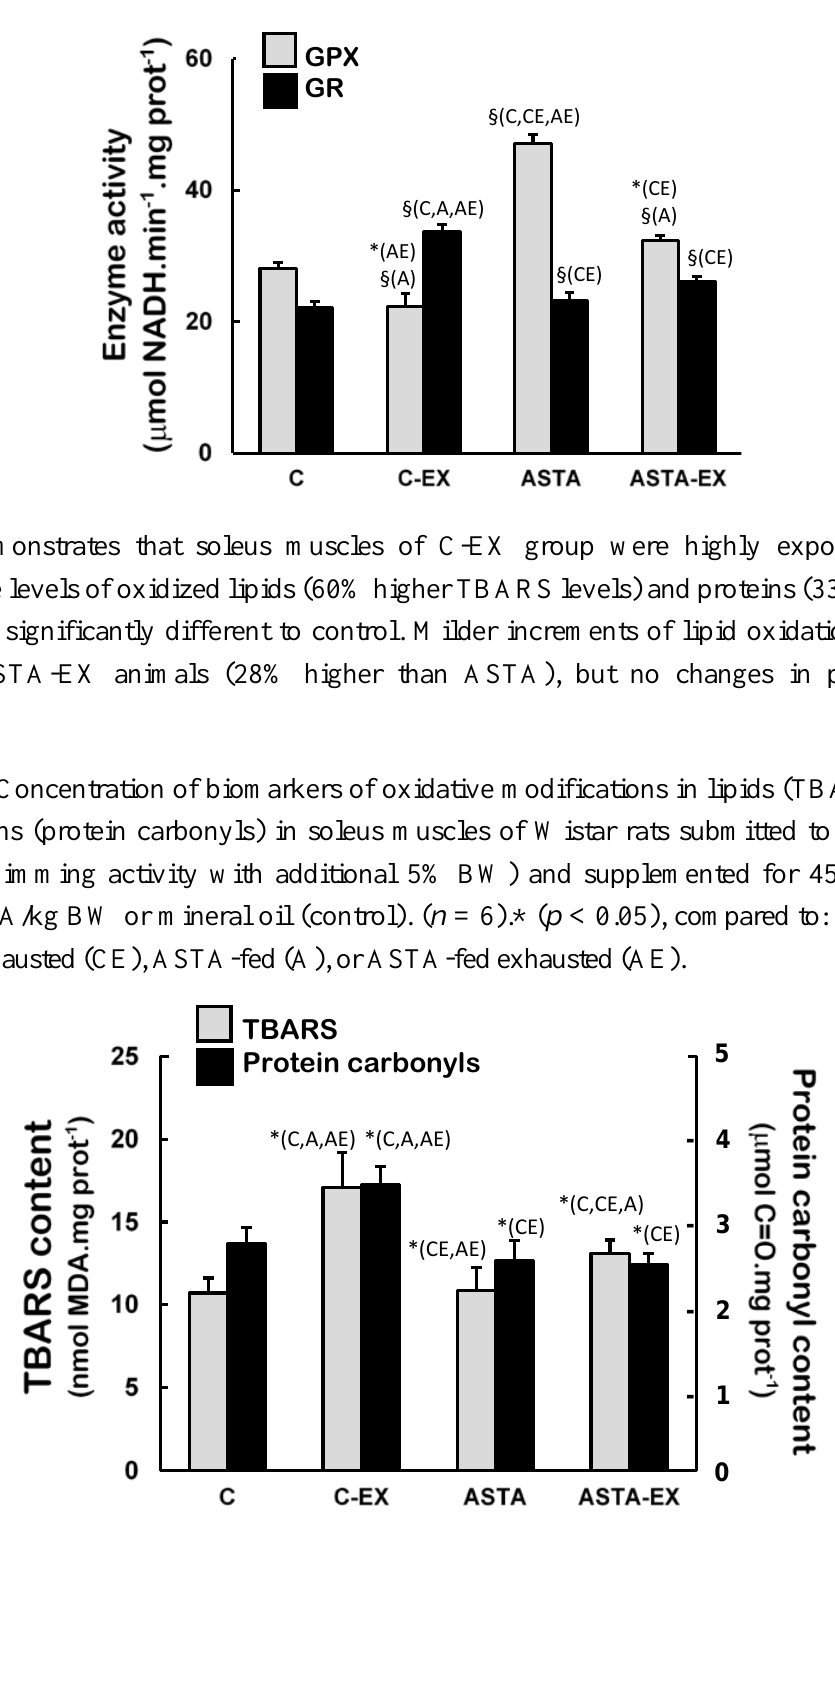
Figure 5. Enzyme activities of glutathione peroxidase (GPX) and glutathione reductase (GR) in soleus muscles of Wistar rats submitted to exhaustion (forced swimming activity with additional 5% BW) and supplemented for 45 days with 1 mg ASTA/kg BW (ASTA or ASTA-EX) or mineral oil as control (C or C-EX). ( n = 6).* ( p < 0.05); § ( p < 0.005), compared to: control (C), control exhausted (CE), ASTA-fed (A), or ASTA-fed exhausted (AE).